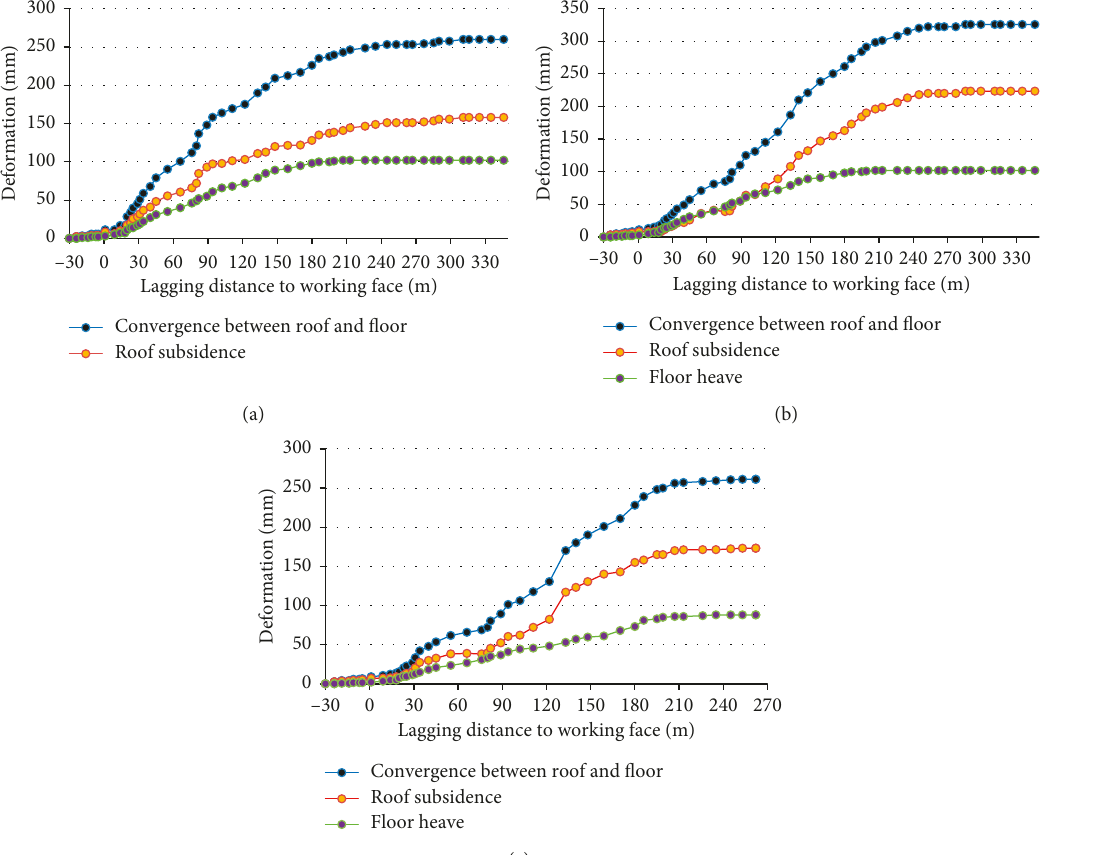
Figure 12: Monitoring results of retained entry deformation by the cross-point method: (a) footage 100m, (b) footage 300 m, and (c) footage